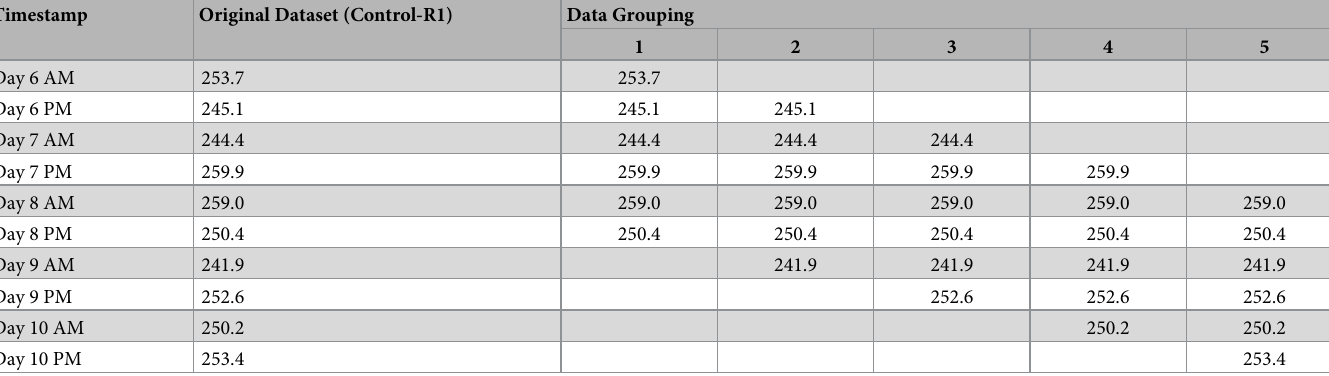
Table 2. Example of staggering method to generate data for the machine learning model.